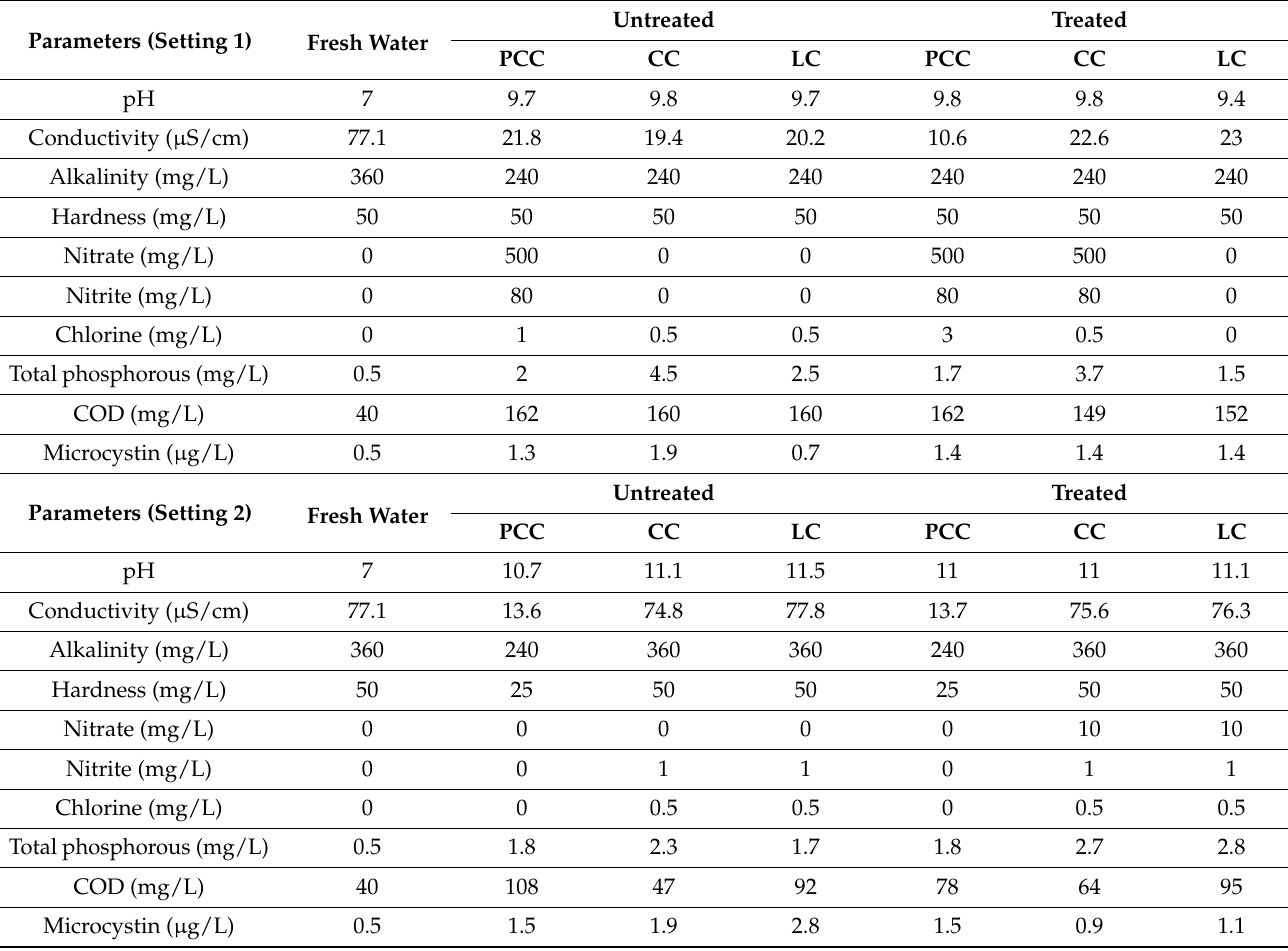
Table 2. Descriptive parameters and water quality analysis of untreated and treated samples of PCC7806, Cibolo Creek and Leon Creek, after 30 days of experiment and fresh water from day 1 of setting 1 (algal interaction) and setting 2 (heterotrophic